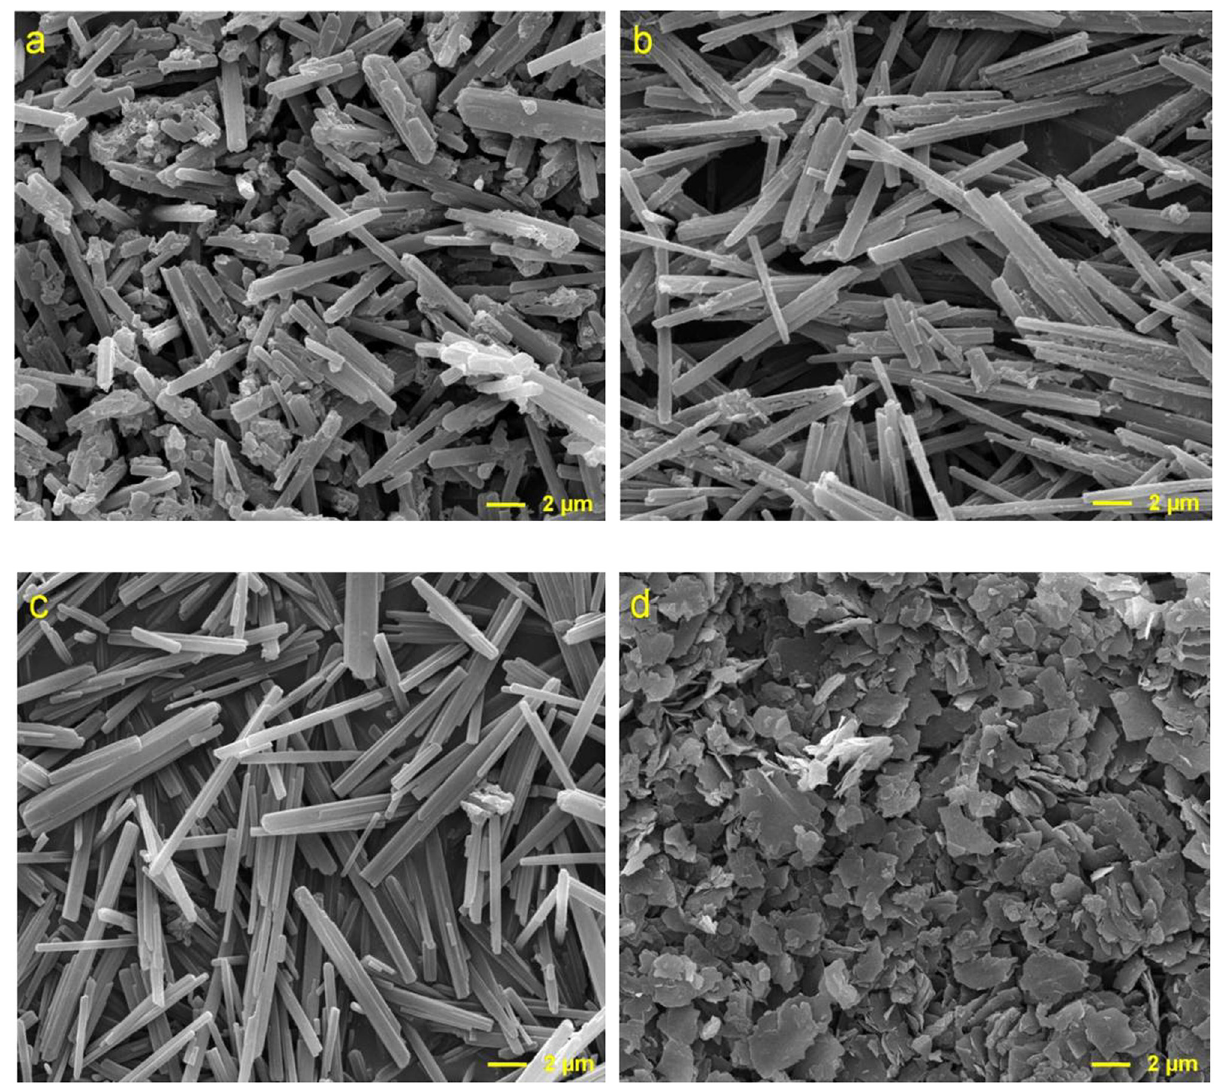
Figure 2: SEM images for the carbonation products with di ff erent carbonation temperatures: ( a ) 40°C, ( b ) 50°C, ( c ) 60°C, and ( d )